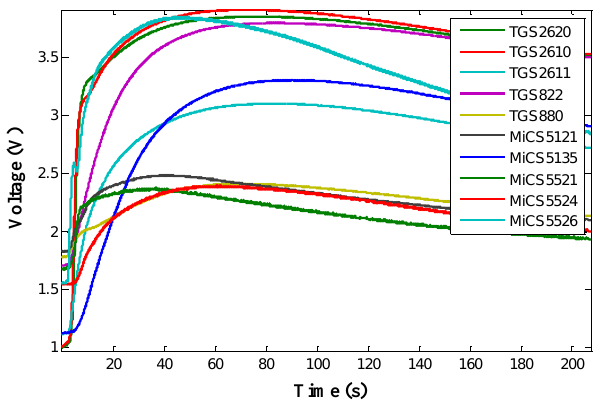
Table 5. Recognition results and employed time based on traditional methods and DL methods.